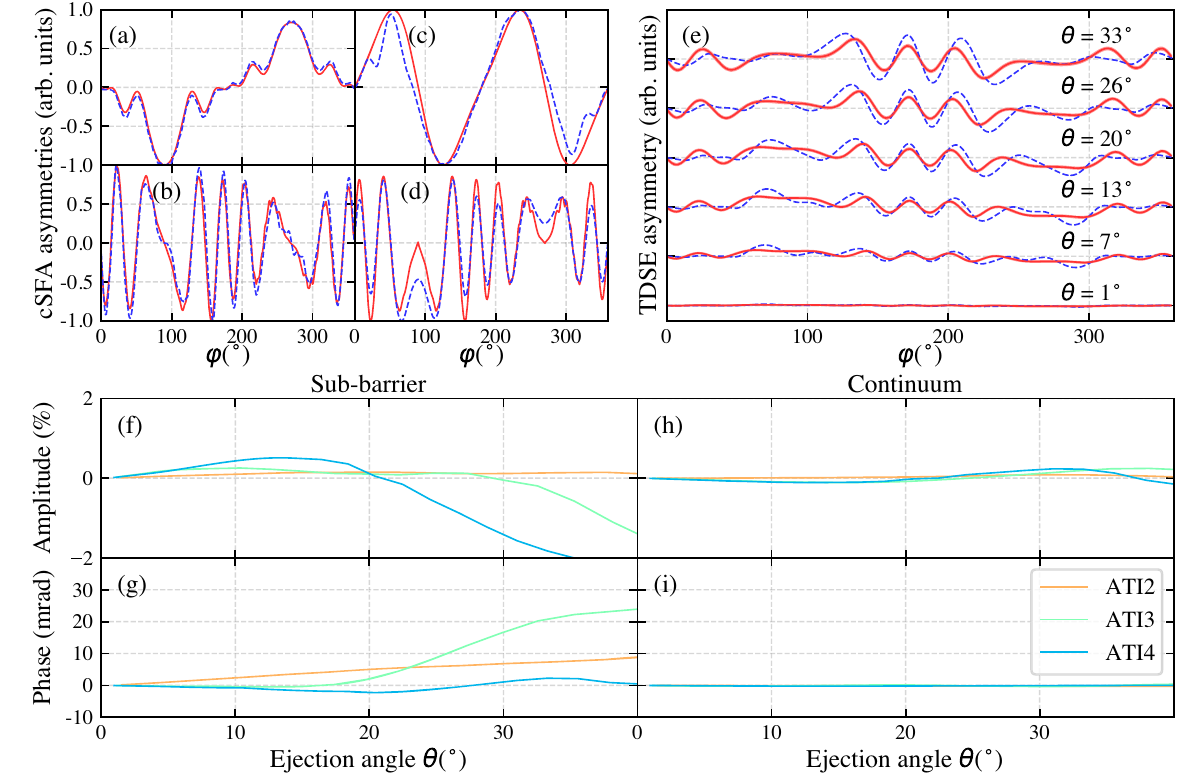
FIG. 7. Extracting the subcycle gated chiral response from TDSE calculations in a Yukawa-screened molecule, driven by an OTC field with I ω ¼ 5 × 10 13 W · cm − 2 , r ¼ 0 . 1 , and ϕ ¼ 0 . (a) Forward-backward asymmetries stemming from instantaneous sub-barrier amplitude effects in the chiral-SFA model (dashed lines) and calculated according to Eq. (6) (continuous lines), as a function of the streaking angle φ for ATI2 electrons ejected along θ ¼ 30 °. (b) – (d) The same as (a) but for instantaneous sub-barrier phase, accumulated continuum amplitude, and accumulated continuum phase effects, respectively. (e) φ dependence of the forward-backward asymmetry obtained by means of TDSE calculations involving the Yukawa screened potential for ATI2 electrons ejected along selected values of θ (dashed lines) and associated fits according to Eq. (10) (continuous lines). (f) Chiral sub-barrier amplitude modulations a f=b 1 ð p; θ Þ extracted from the fits due to instantaneous tunneling for ATI2 – 4 electrons (from orange to blue) as functions of θ . (g) Chiral differences Δ η f=b p; θ Þ in the relative phase between direct and indirect wave packets at the exit of the tunnel. (h) Chiral amplitude modulations 2 ð a f=b p; θ Þ accumulated in the continuum. (i) Chiral differences Δ η f=b p; θ Þ in the relative phase between direct and indirect wave 3 ð 4 ð packets accumulated in the